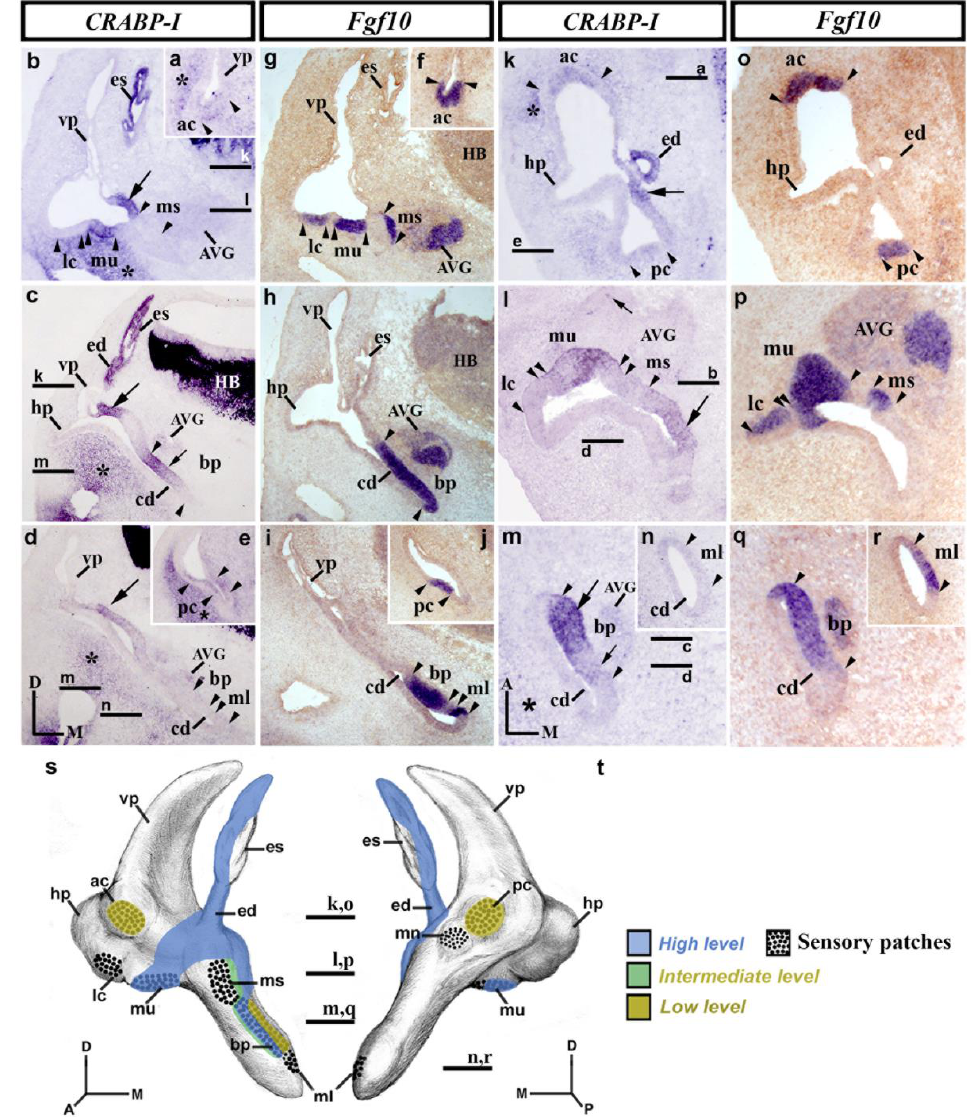
Figure 3. CRABP-I expression patterns at stage HH27. Transverse ( a – j ) and horizontal ( k – r ) sections through the inner ear anlagen treated with the CRABP-I ( a – e , k – n ) and Fgf10 ( f – j , o – r ) probes. The presumptive areas of the developing sensory patches are indicated between arrowheads in all pictures. At this stage, the anterior and posterior cristae exhibited very weak CRABP-I labeling (ac and pc in ( a , e , k )), whereas the lateral crista was CRABP-I negative (lc in b , l ). The macula utriculi display CRABP-I expression (mu in ( b , l )). The macula sacculi and macula neglecta were devoid of CRABP-I expression (ms in ( b , l ); mn, not shown). The wall of the endolymphatic apparatus (es and ed in b , c , k ) and a portion of the vestibular wall at which it inserts (large arrow in ( b - d , k )) were CRABP-I positive. In the developing cochlear duct (cd in ( c , d , h , i , m , n , q , r )), CRABP-I expression was detected in its medial wall (small arrows in ( c , m ); large arrow in ( m )), including the developing basilar papilla (bp in ( c , m )). The macula lagena was CRABP-I negative (ml in ( d , n )). At this stage, a few cells of the acoustic-vestibular ganglion were CRABP-I positive (AVG; small arrow in ( l )). Some regions of the mesenchyme underlying the otic epithelium were CRABP-I stained (asterisks in ( a – e , k , m )). ( s , t ), 3D CRABP-I expression pattern diagrams in anterior ( s ) and posterior ( t ) views of the stage HH27 inner ear. Dotted areas show the sensory patches. For the abbreviations, see the list. Orientation: A, anterior; D, dorsal; M, medial; P,